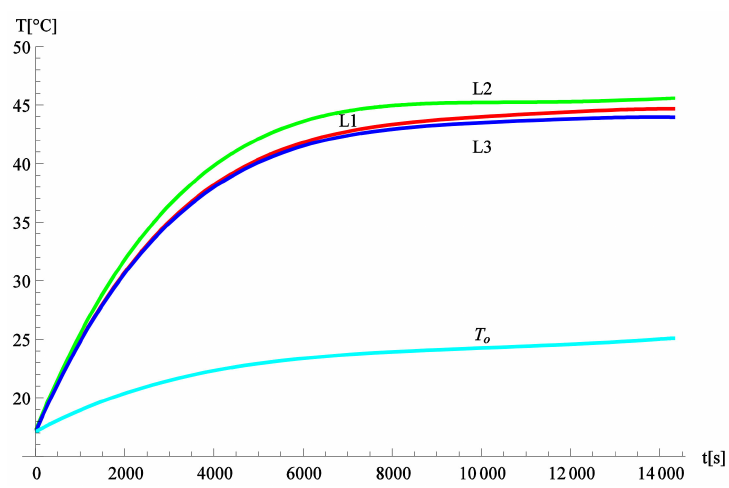
Figure 4. Time variation of the phase conductor temperature: measurements (L1, L2, L3: phase conductors; T o : ambient temperature).